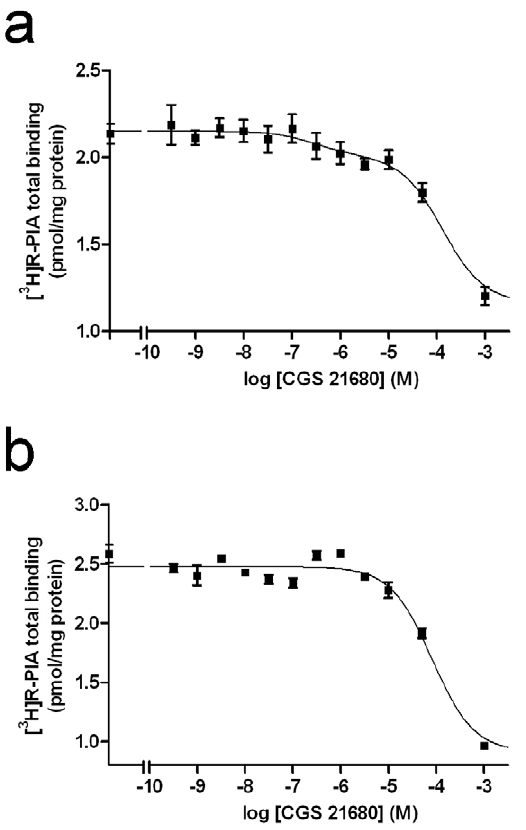
Figure 6. Allosteric interaction between A 1 R and A 2A R in A 1 R- A 2A R CHO cells. Competition experiments were performed in membrane preparations from CHO cells expressing A 1 R or A 1 R and A 2A R with 12 nM [ 3 H]R-PIA versus increasing concentrations of the A 2A R agonist CGS-21680 as indicated in Methods. Data represent means 6